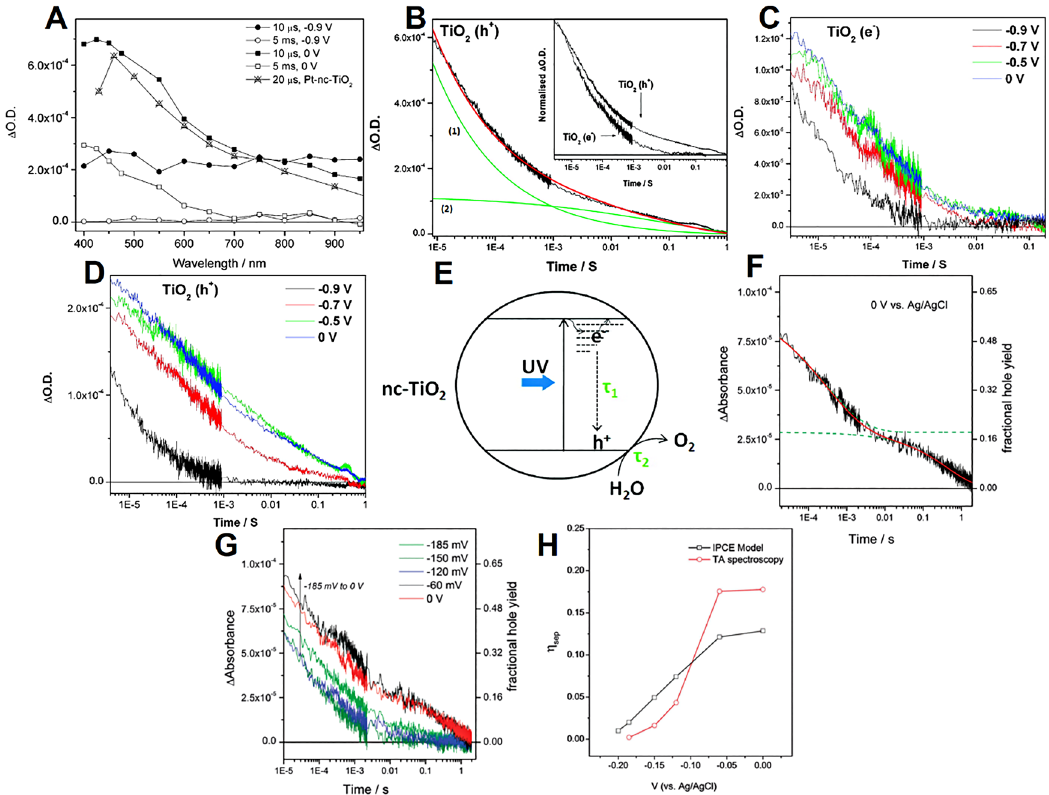
Figure 2: (A) In situ transient absorption(TA) spectra of nc-TiO 2 recorded at − 0.9 and 0 V in 0.05 M NaOH at 10 μ s and 5 ms after UV excitation (355 nm, 250 μ J cm − 2 ). The Pt-nc-TiO 2 spectrum was adopted from the literature [70]. (B) TA pro fi le of the photoholes (460 nm) at 0 V. Inset highlightsthedifferenceintheTApro fi lebetweenthephotoholes(460nm)andtrappedphotoelectrons(800nm).(C – D)TApro fi lesoftrapped photoelectrons (C panel) and photoholes (D panel) under different applied biases. (E) Proposed charge dynamics mechanism of nc-TiO 2 . ReprintedwithpermissionfromastudybyCowanetal.[38].Copyright2010AmericanChemicalSociety.(F)TApro fi leofphotoholesfornc-TiO 2 (460 nm) at 0 V in 0.5 M NaClO 4 under UV excitation (355 nm, 35 μ J cm − 2 ) and its correlation with the fractional yield of photoholes. (G) TA pro fi lesofphotoholesunderdifferentappliedbiases.(H)Correlationofthetwo η sep valuesderivedfromincidentphoton-to-currentconversion ef fi ciency (IPCE) and TA measurements with the applied bias under UV excitation (355 nm and 3.7 mW cm − 2 for IPCE; 355 nm and 35 μ J cm − 2 for TA). Reprinted with permission from a study by Cowan et al. [40]. Copyright 2013 Royal Society of